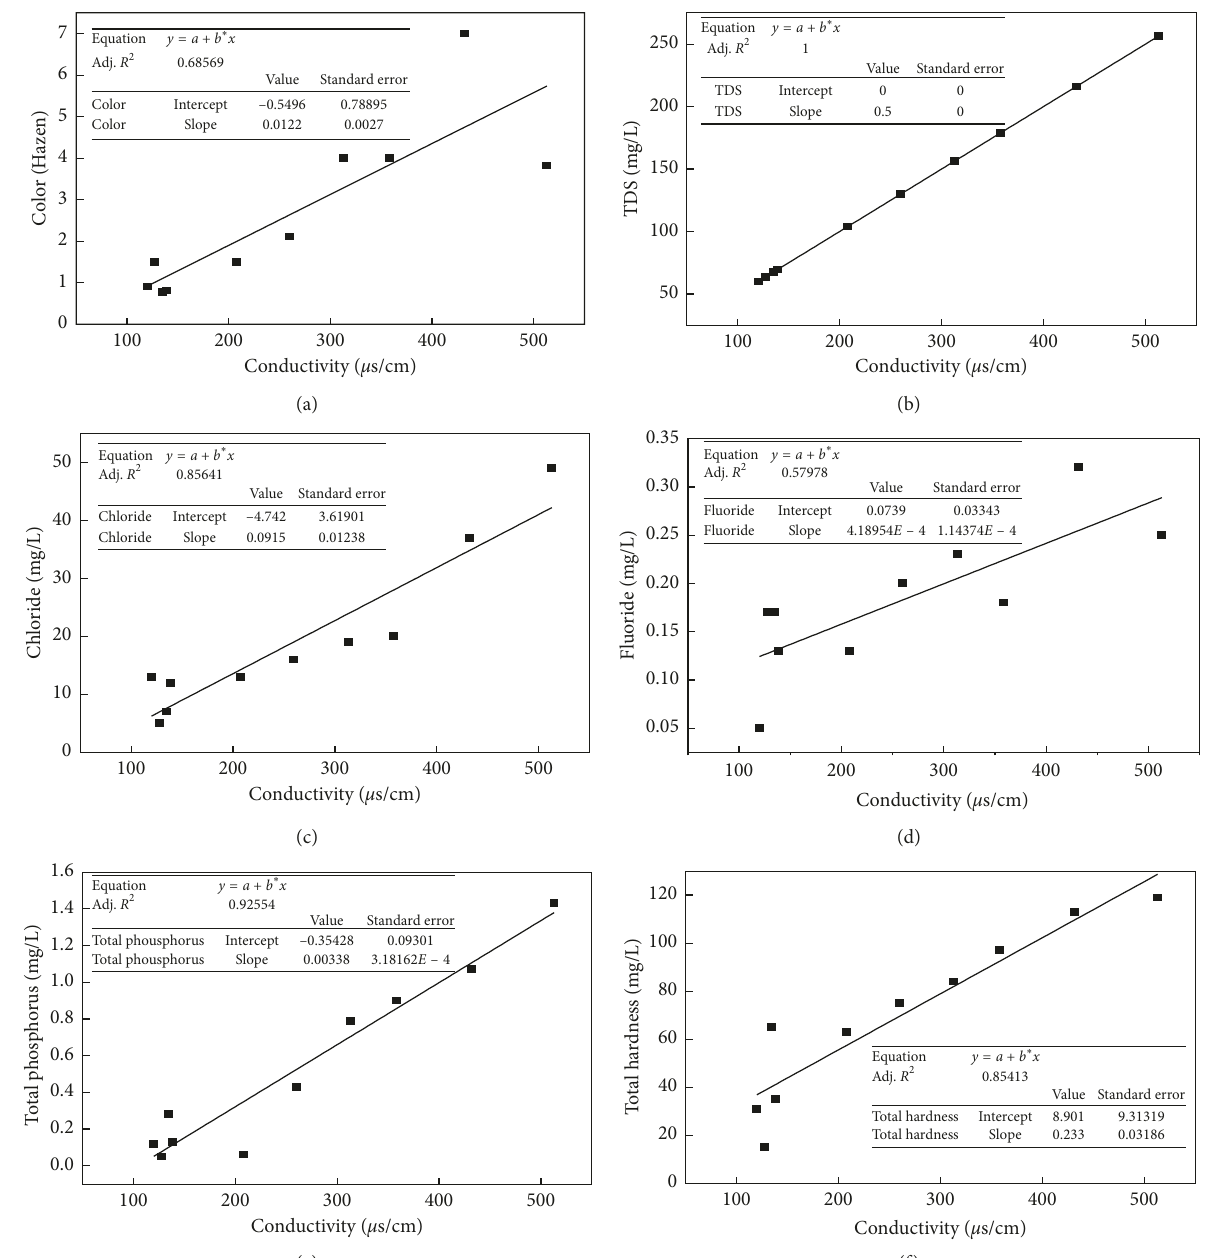
Figure 2: Correlation of color, TDS, chloride, flouride, total phosphorus, and total hardness with electrical